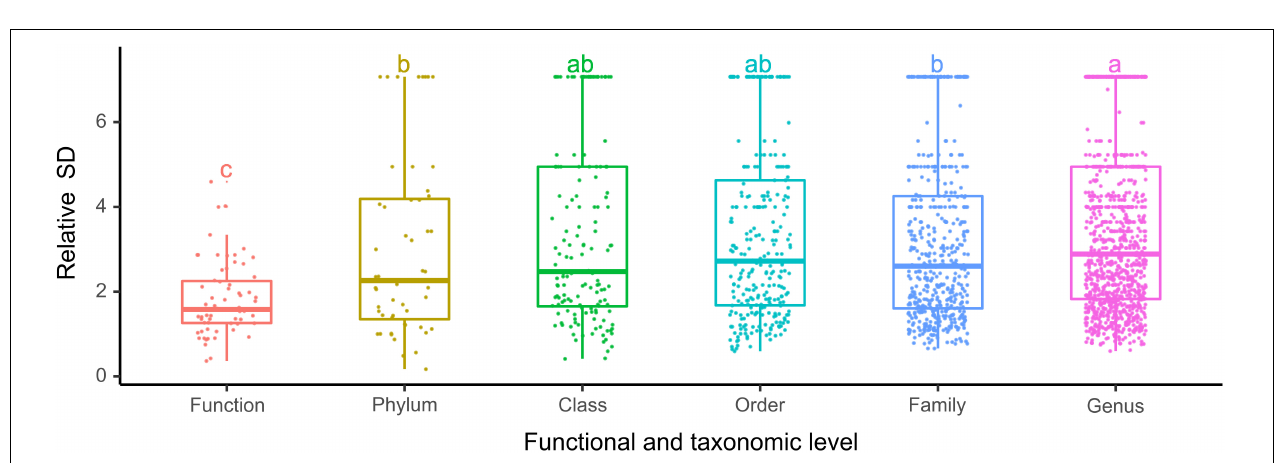
FIGURE 3 | The relative SD of bacterioplankton taxonomic and functional variability in the overwintering ground. Different lowercase letters denote significant differences ( p < 0.05) among levels based on one-way ANOVA.